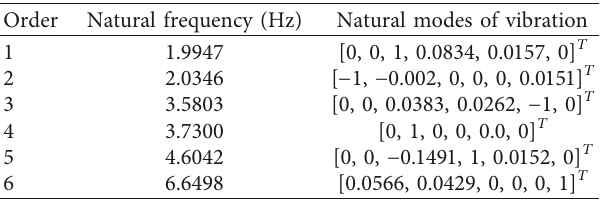
Table 2: Modal calculation results of the vibrating screen (1 ∼ 6 order).